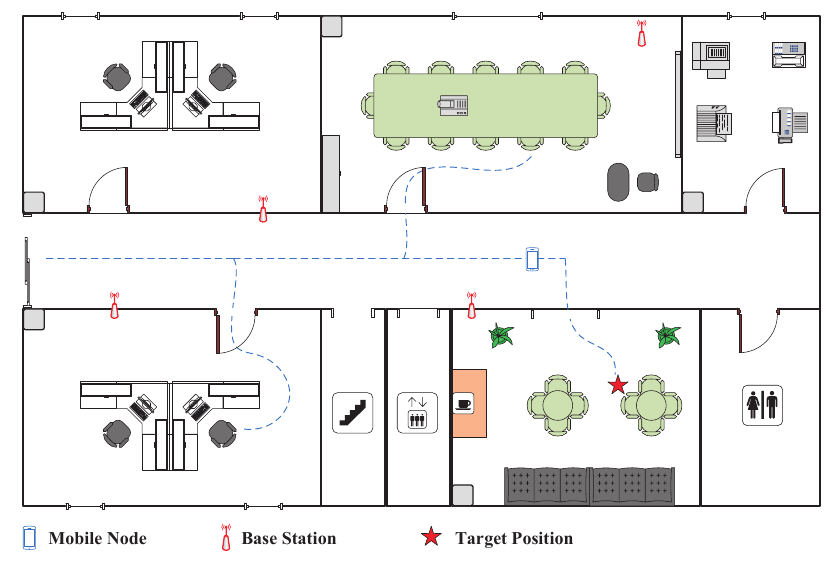
Figure 1. The Wi-Fi-based indoor position